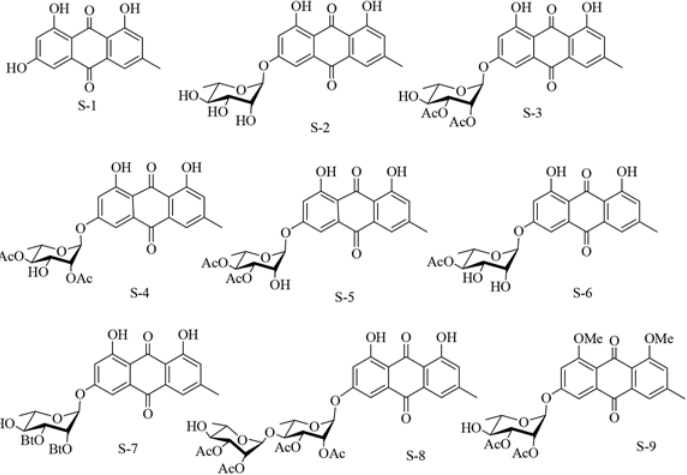
Fig 2. Chemical structures of emodin rhamnopyranosides